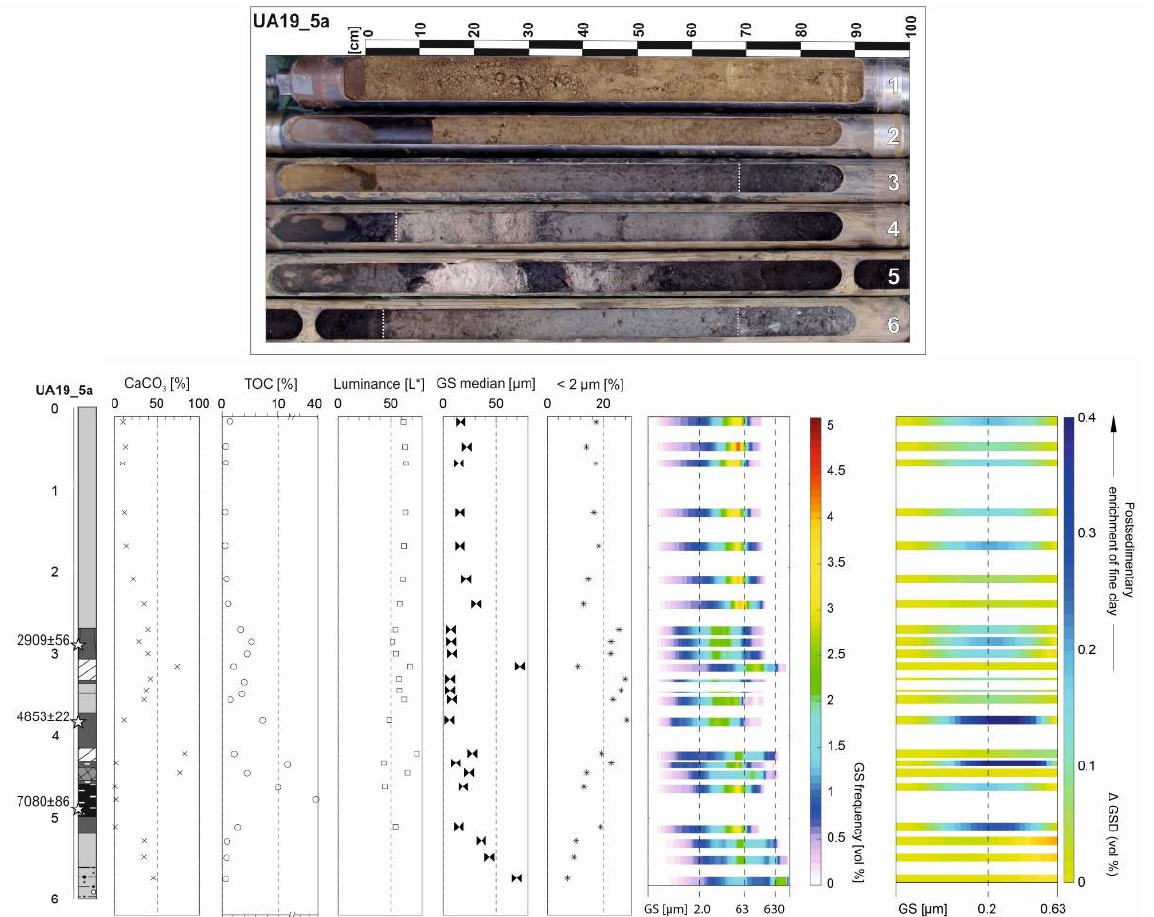
Figure 8. ( Top ) Drilling core UA19_5a showing matrix-supported gravels (>5.7 m) covered by basal overbank fines (5.05 to 5.7 m). From 3.1 to 5.05 m “rieth series” deposits with interbedded overbank fines (3.3 to 4.1 m) were drilled. Between 2.7 and 3.1 m humic overbank fines were recovered, changing to homogeneous yellowish brown to greyish brown overbank fines in the uppermost 2.7 m. ( Bottom ) Laboratory results obtained for drilling core UA19_5a. The schematic illustration (left of the graphs) refers to Figure